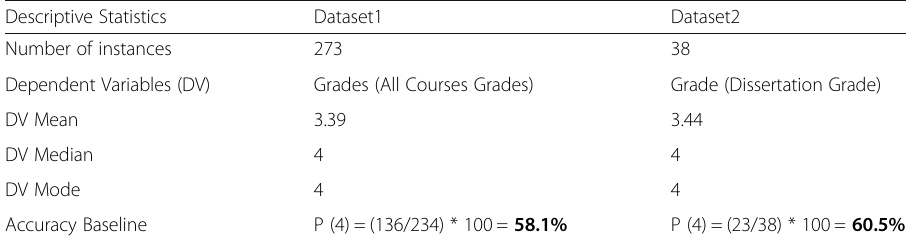
Table 2 Summery statistics for dataset 1 and